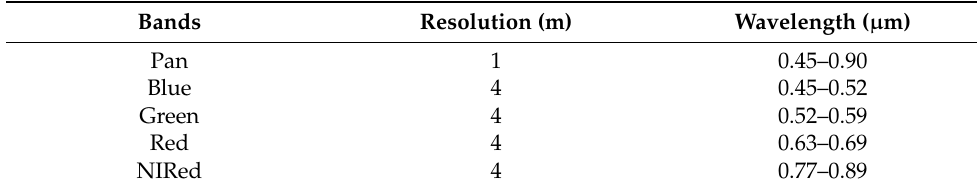
Table 1. Satellite parameters of